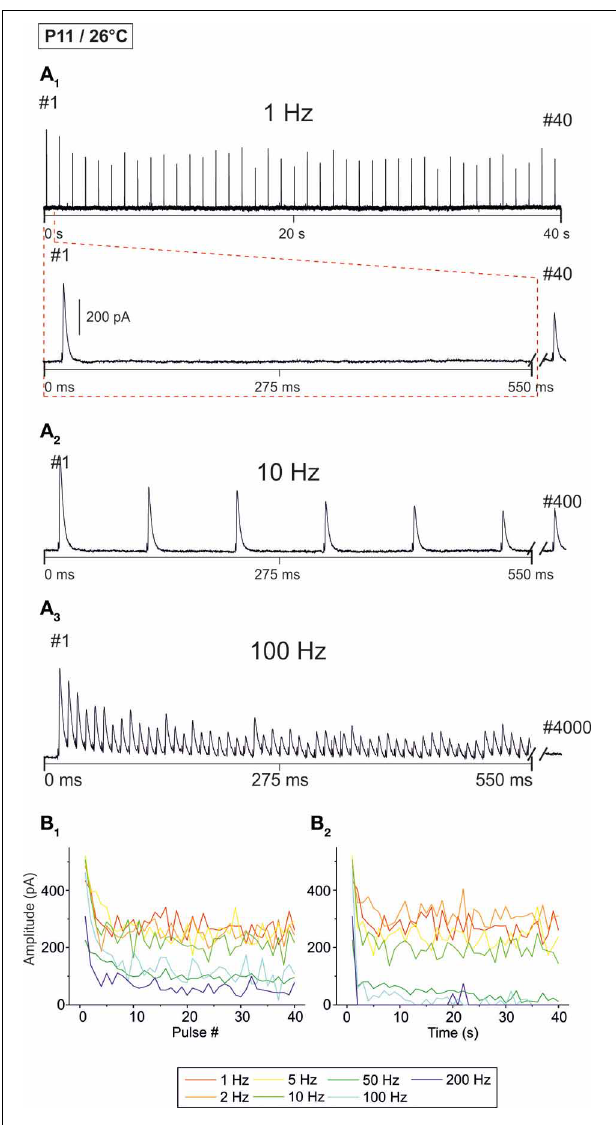
FIGURE 4 | Frequency-dependent changes in evoked glycinergic IPSCs obtained at P11 and room temperature (26 ± 2 ◦ C). (A 1 ) Original 40s recording of a representative LSO neuron during 1Hz stimulation (top). The first550msaretime-expandedinthebottomtrace(seered-stippledline).The last IPSC during the 40-s-period is shown on the right and depicted by its pulsenumber(#40).The200pAcalibrationbarisalsovalidforpanels (A 2 ,A 3 ) . (A 2 ,A 3 ) IPSCs during 10 and 100Hz stimulation, respectively, from the same neuronasinpanel (A 1 ) .Similarto (A 1 ) ,thelastIPSCduringthe40-s-periodis shown on the right (#400 and #4000, respectively). ( B 1 ) Time course of IPSC peak amplitudes from two LSO neurons at stimulation frequencies ranging from 1–200Hz (for color code, see inset). Peak values to the first 40 pulses (pulse #1–40) are plotted. ( B 2 ) , Like (B 1 ) , but depicting the time course of IPSCpeakamplitudesduringthecomplete40-s-periods.Foreachstimulation frequency, peak amplitudes were sampled at 1-s-intervals. Notice the stronger amount of STD than at 37 ◦ C, particularly at higher